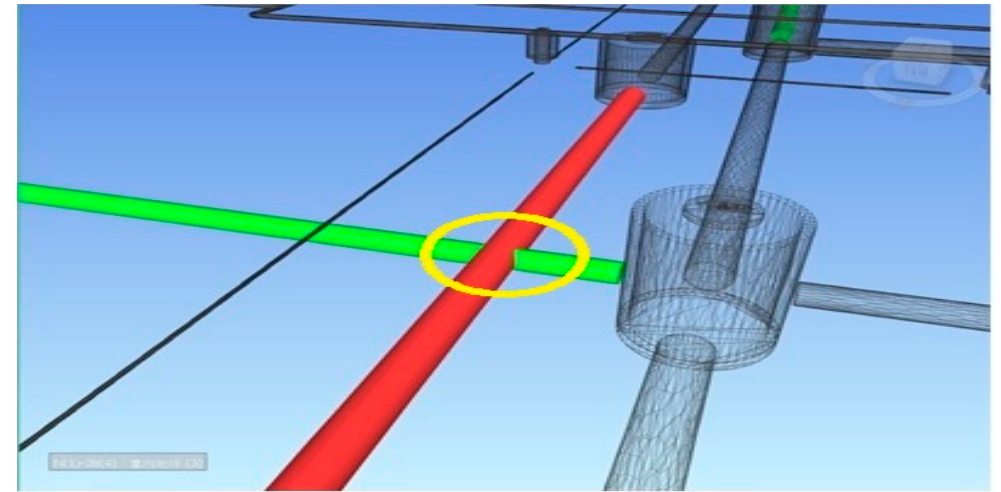
Figure 15. The clash between the water pipeline and the rainwater pipeline.